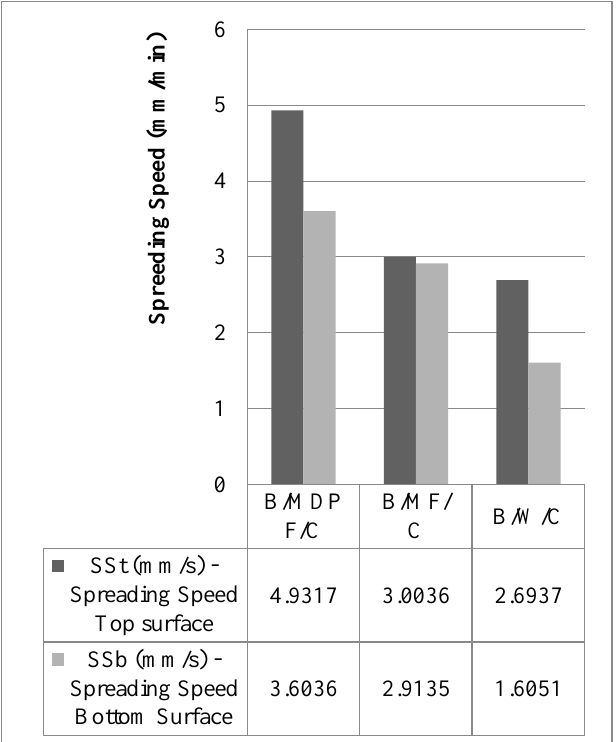
Fig. 4. Spreading speed of trilayer knitted fabrics